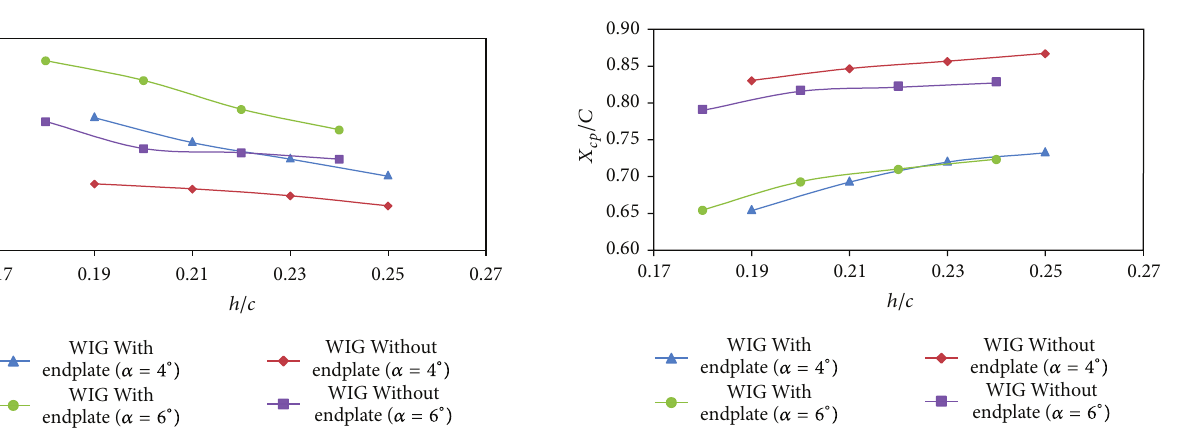
Figure 10: The position of the center of pressure ( 𝑋 𝑐𝑝 ) of WIG craft model with and without endplates versus ground clearance ( ℎ/𝑐 ) at different angles of